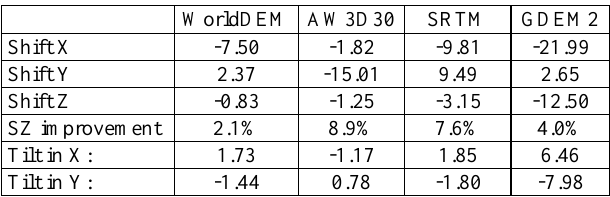
Table 2: Shift and tilt against reference LiDAR DSM [m] and improvement of standard deviation of Z by shift in X and Y, range X: 25.5km, range Y: 21.6km